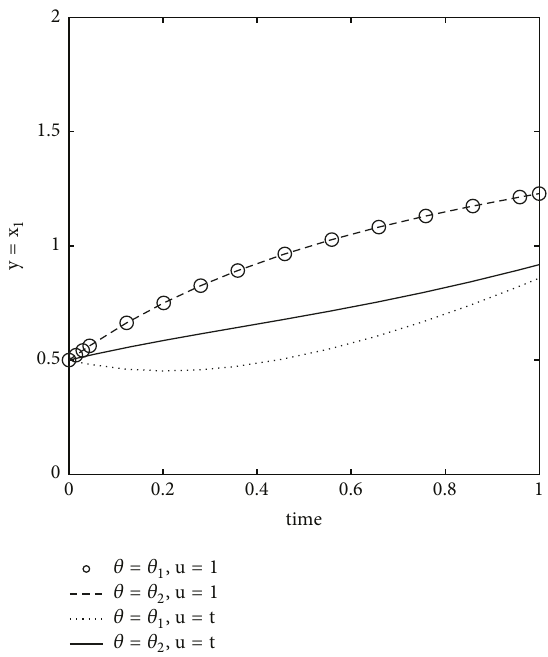
Figure 2: Output of the two-compartment model of (19) for two different parameter vectors ( 𝜃 1 given by 𝑘 1𝑒 = 1, 𝑘 12 = 3, 𝑘 21 = 𝑘 = 2, 𝑘 = 2.5,𝑘 = 0.5,𝑏 = 2 ), 1,𝑏 = 1 , and 𝜃 2 given by 1𝑒 12 21 and two different inputs, 𝑢 = 1 and 𝑢 = 𝑡 (where 𝑡 stands for time). With a constant input 𝑢 = 1 both parameter vectors are indistinguishablefromthe modeloutput(thereisactually aninfinite number of pairs of indistinguishable parameter vectors), and the parameters are structurally unidentifiable. However, with a ramp input 𝑢 = 𝑡 twodifferentparametervectorsyieldtwodifferentmodel outputs; in this case the parameters are structurally